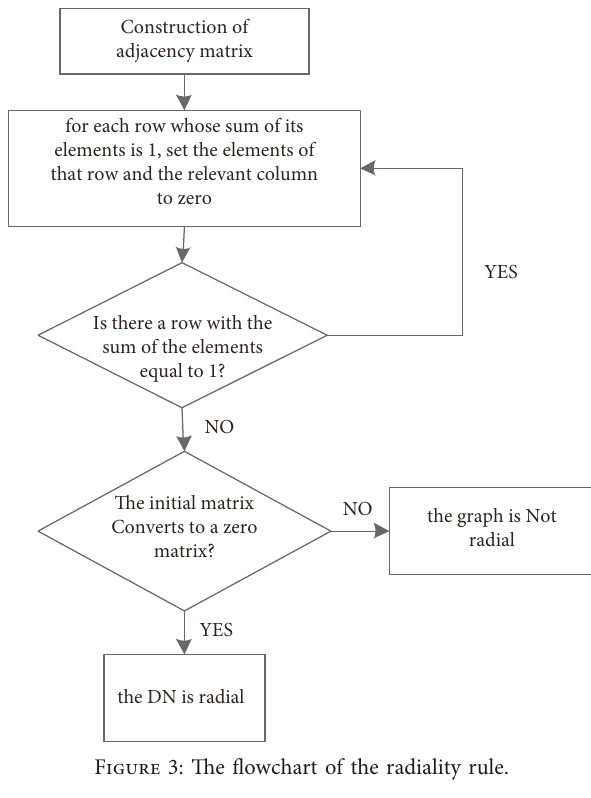
Figure 3: The flowchart of the radiality